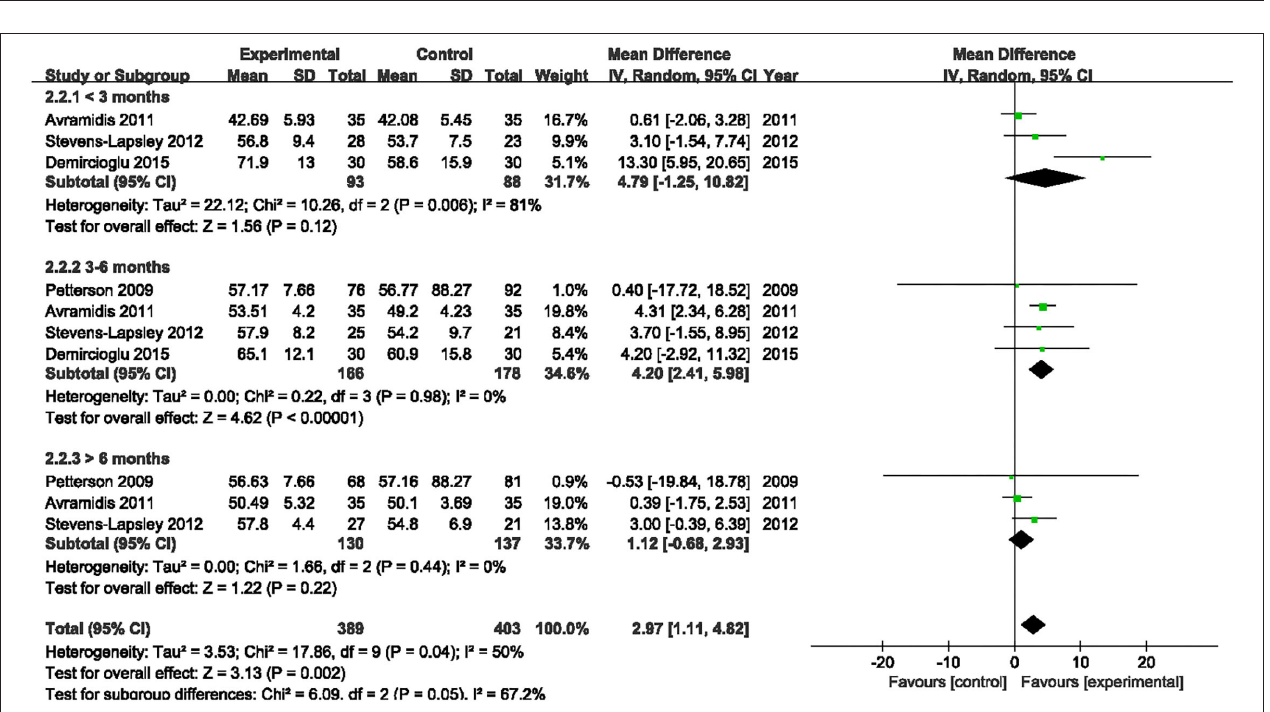
FIGURE 14 | Forest plots of meta-analysis of the effect of NMES vs. conventional rehabilitation on SF-36 PCS.